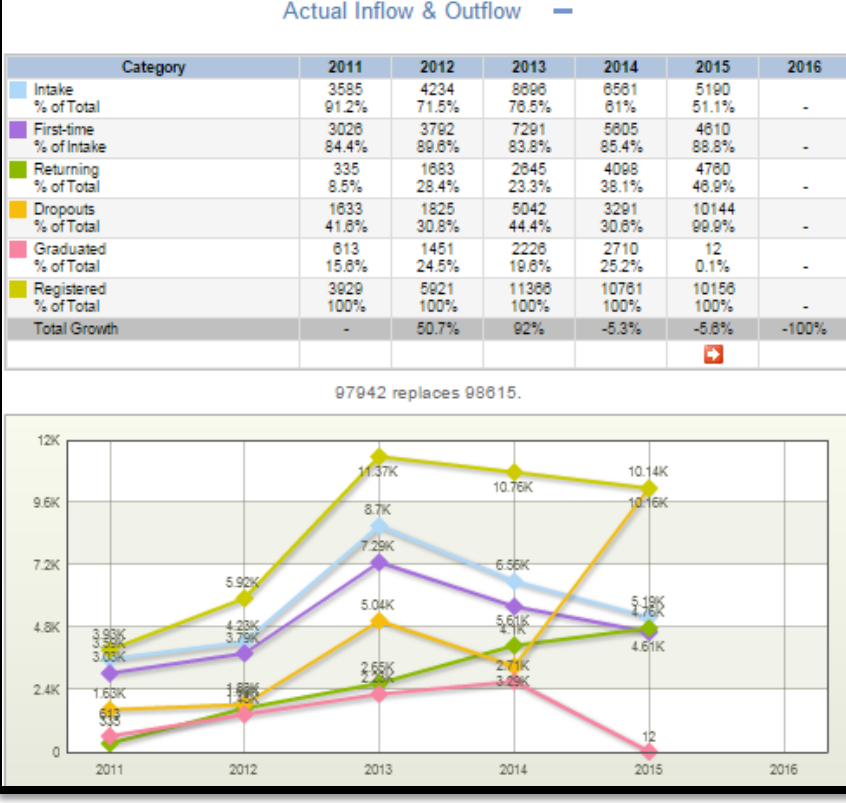
Figure 8. Excerpt qualification flow planning view - actual inflow and